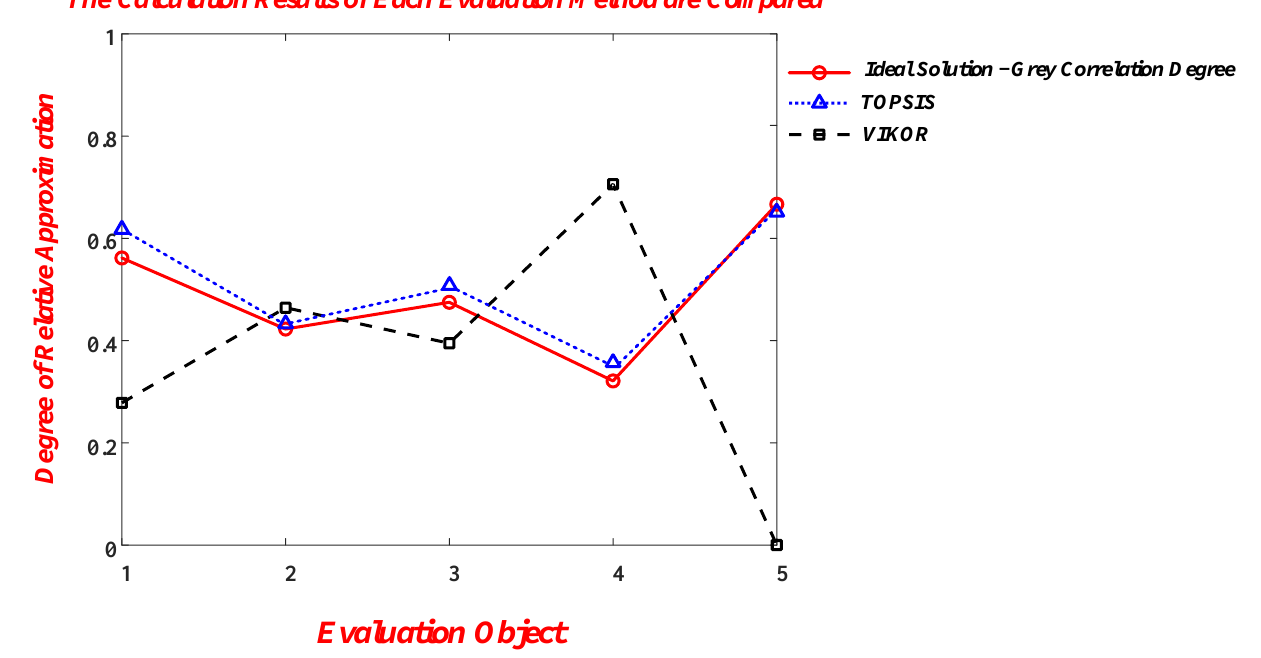
Figure 6. Comparison of multi-method evaluation results.